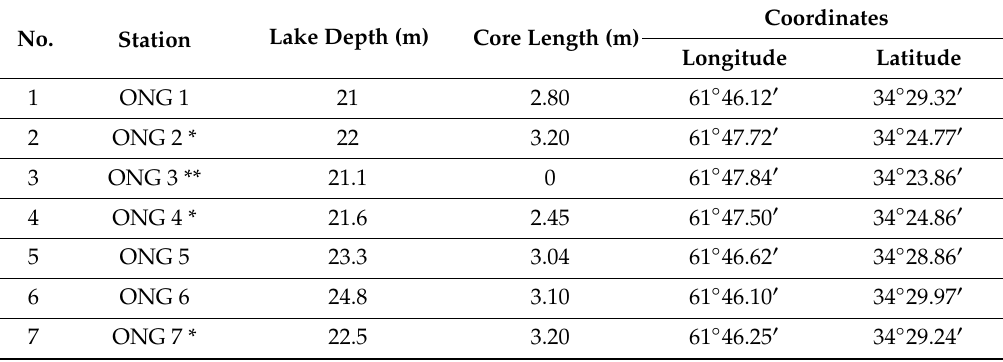
Table 1. Coordinates, water depth, and core lengths of the